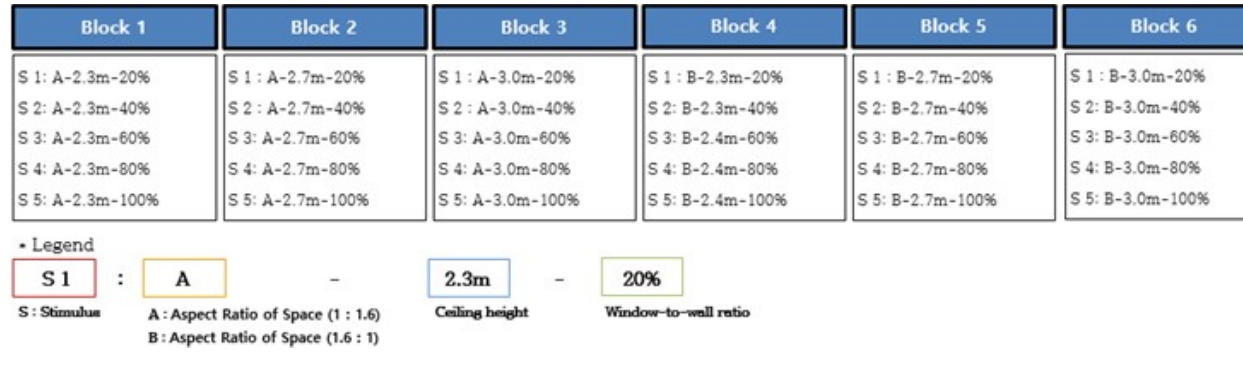
Figure 6. VR visual stimulation.